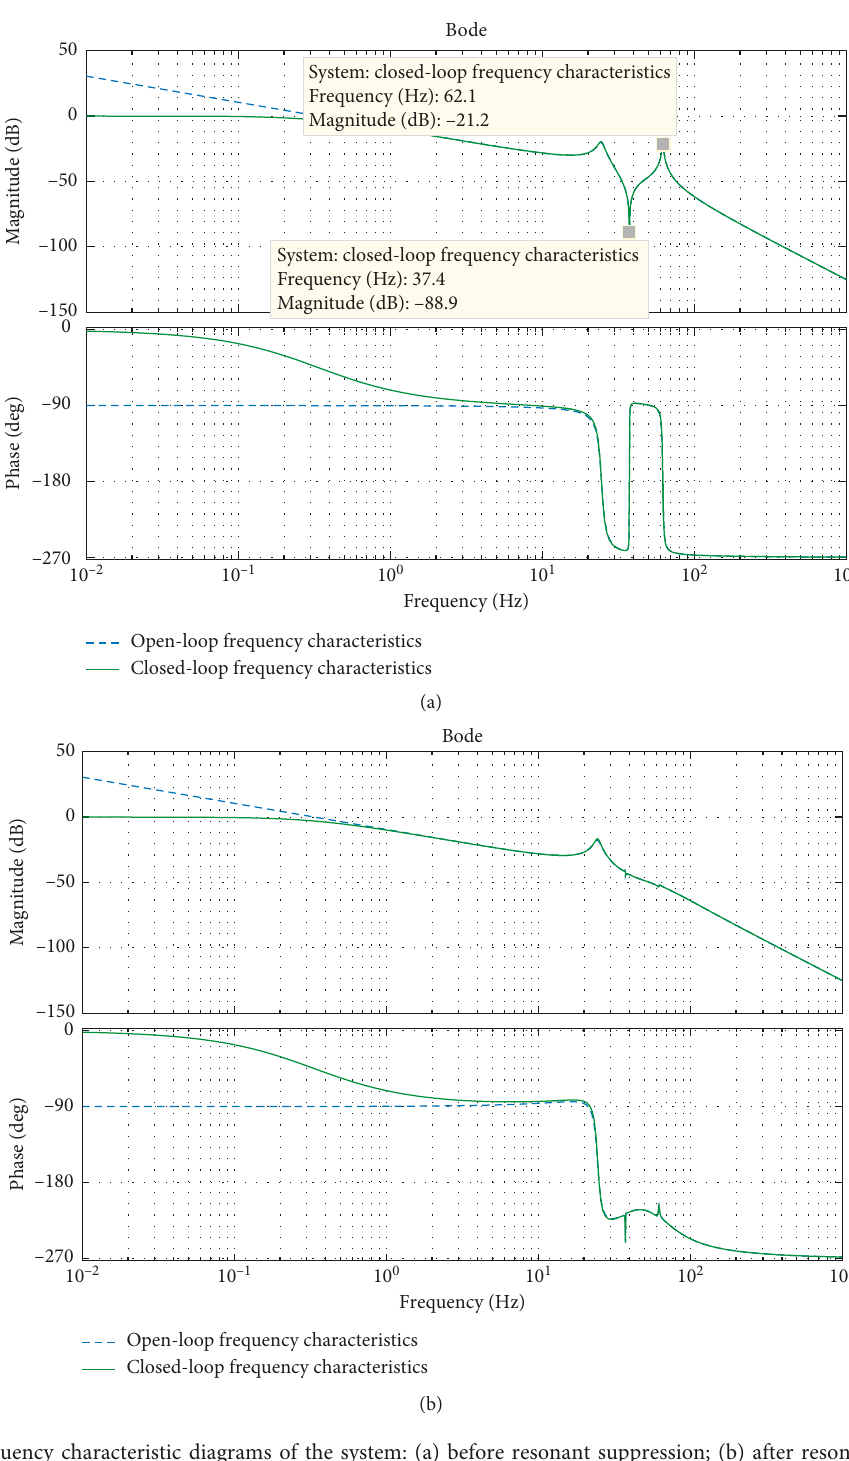
Figure 8: Frequency characteristic diagrams of the system: (a) before resonant suppression; (b) after resonant